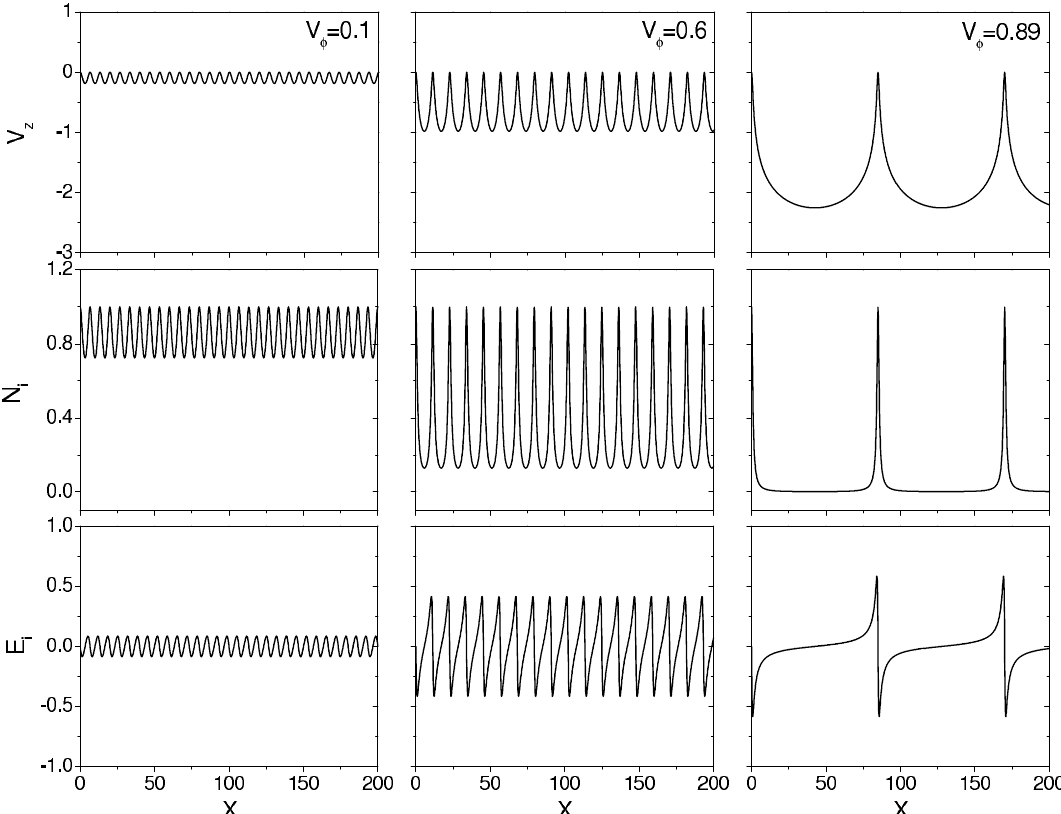
Fig. 2. Same as Fig. 1 but that of the backward-propagating branch of solitary-waves. Note that the density structures are totally the same as those in the previous